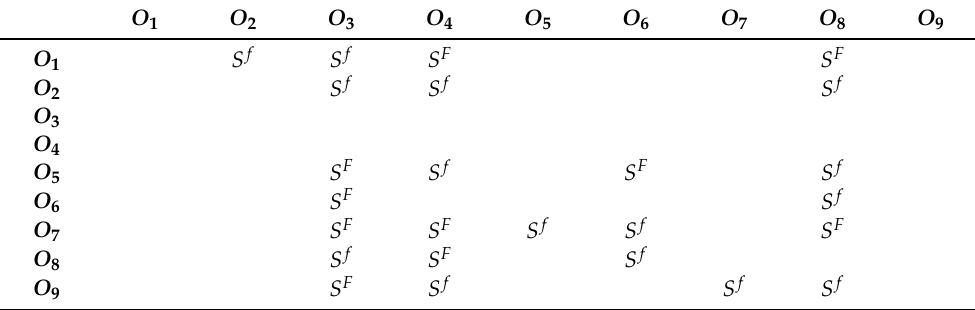
Table 22. Strong and weak outranking relations for traditional ELECTRE